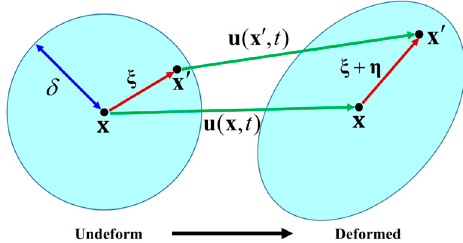
Figure 2. Initial and deformed configuration in peridynamics.